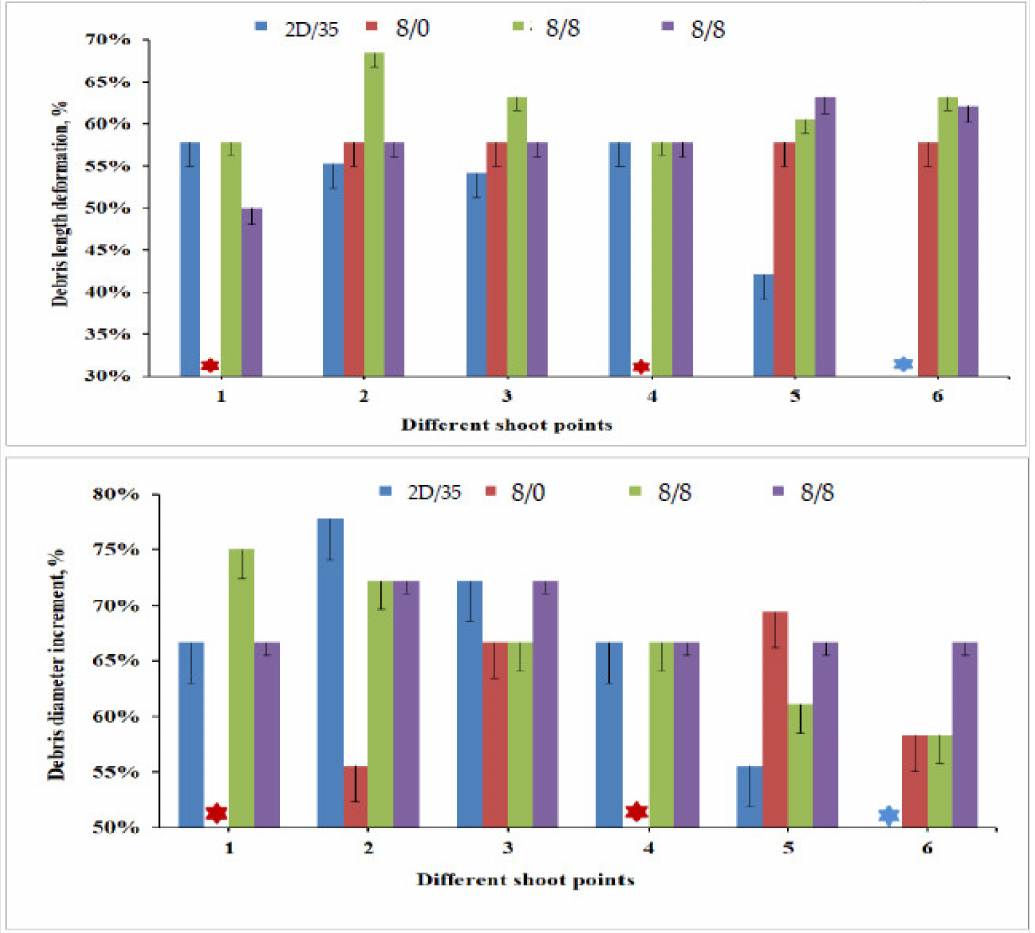
Figure 10. The residual projectile debris deformational percentage for armour panels at various shot points. All shots penetrated for armour panel (4/8), armour panel (8/0) penetrated at shots 1 and 4